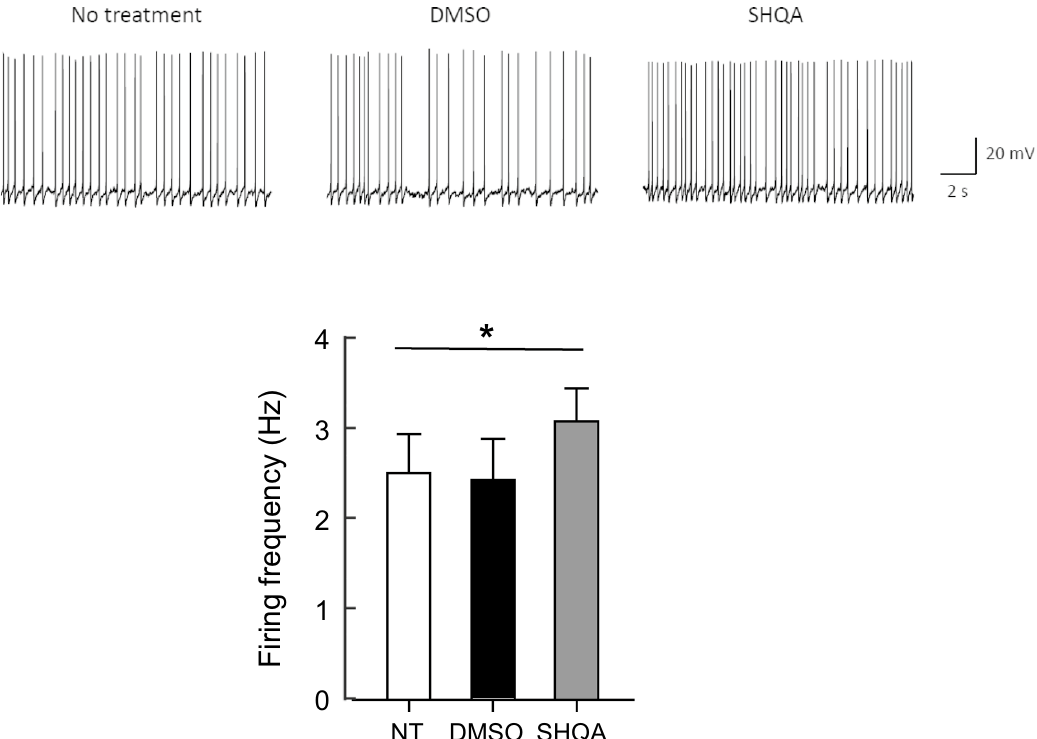
Figure 1. SHQA increases the frequency of spontaneous firing in ARC neurons. Hypothalamic ARC neurons were whole-cell patched under a current-clamp configuration and a change in the spontaneous firing frequency was monitored before and after the application of DMSO or SHQA (4.3 ng/µl). Data are expressed as mean ± S.E.M. (n = 5). Statistical differences between no treatment (NT), DMSO, and SHQA were determined using one-way ANOVA followed by Tukey’s post hoc test: * p <